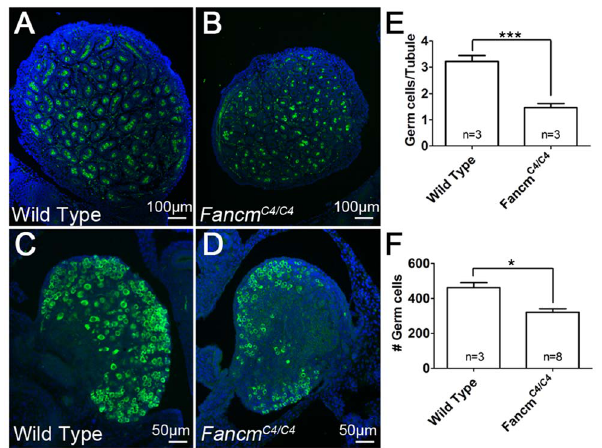
Figure 5. Germ cell depletion in Fancm C4/C4 occurs before birth. Immunofluorescence of 1 dpp testes (A and B) and ovaries (C and D) of the indicated genotypes. MVH (green) stains germ cells and DAPI stains nuclei (blue). (E and F) Germ-cell counts at 1 dpp. Germ cell number is averaged on a per seminiferous tubule cross-section basis for males. Female counts correspond to the total from three medial sections. **, p , 0.01; ***, p , 0.001; Error bars indicate SD.